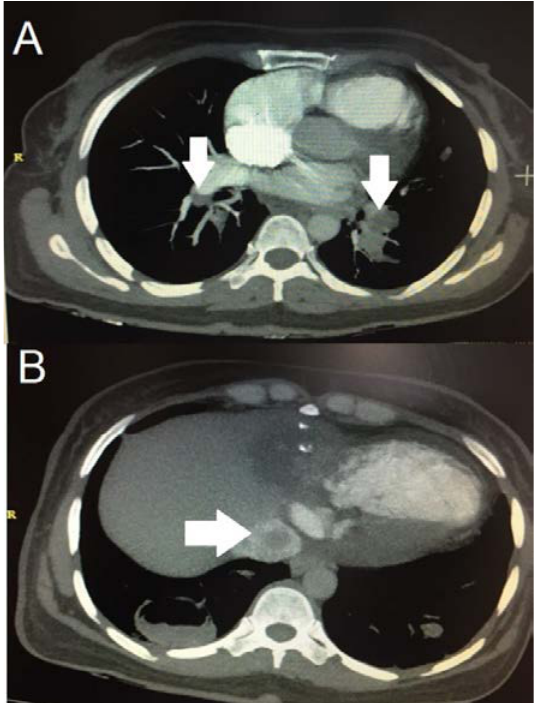
Figure 1. Computed tomography image; A) filling defects in both pulmonary arteries; B) an inferior vena cava filling defect extending toward the